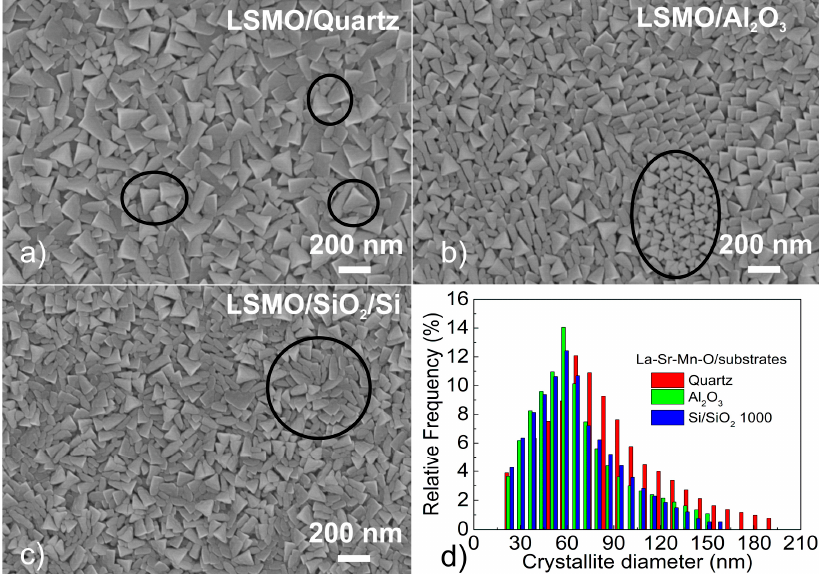
Figure 1. SEM surface images of 360 nm-thick LSMO films grown on different substrates: AT-cut single-crystal quartz ( a ), polycrystalline Al 2 O 3 ( b ), and amorphous Si/SiO 2 substrates ( c ). Distribu- tion of crystallite dimensions (D) for films on different substrates ( d ).